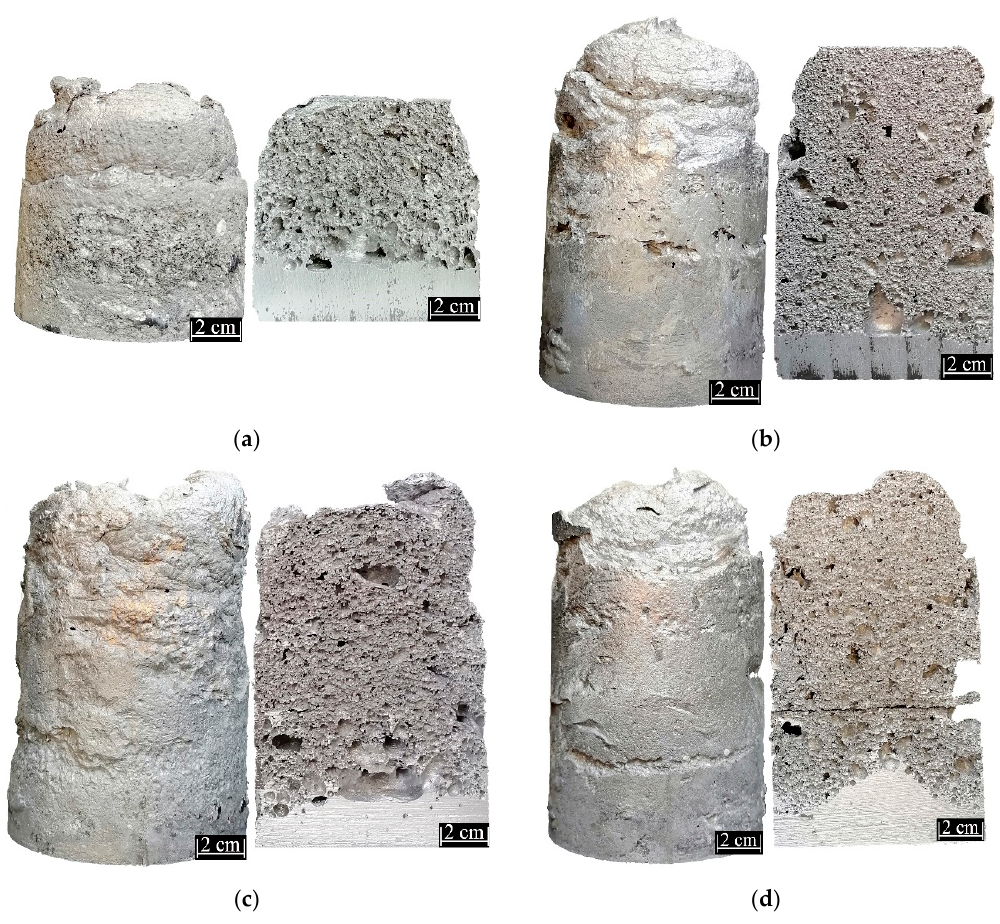
Figure 6. Expansion and cross ‐ section view of the structure of the A356 aluminum alloy foams man ‐